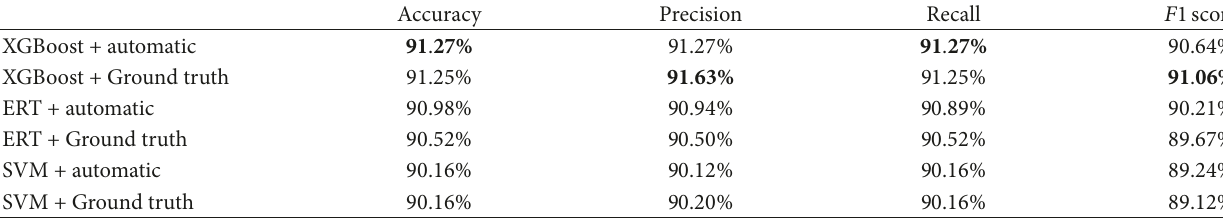
Table 4: Average performance via 5-fold cross-validation.